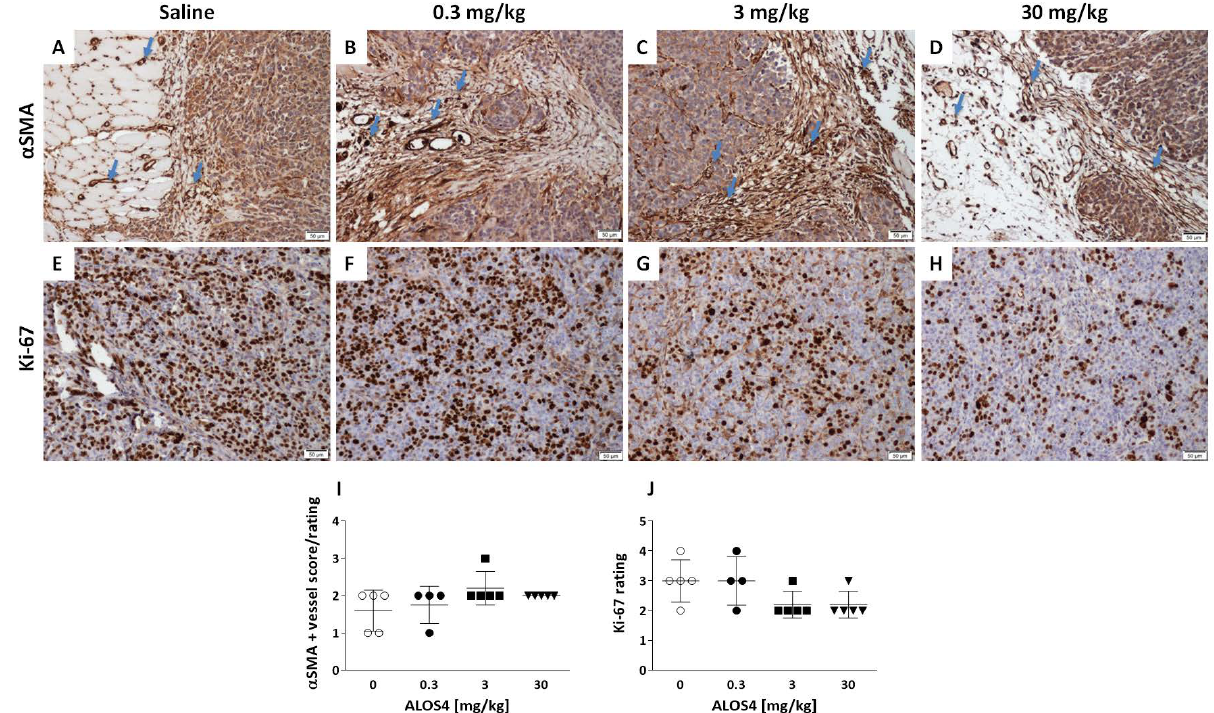
Figure 2. Effect of ALOS4 on carcinogenesis markers presentation in human melanoma A375 SC tumors from nude mice. ( A – D ) Representative photographs of slides stained for α SMA marker showing the number of blood vessels in the tissue sections (10 × ). Arrows demonstrate representative vessels in the tumor tissues. Scale: 50 µ m. ( A ) Tumor of a saline-treated mouse shows low to moderate α SMA expression. ( B ) Tumor of an ALOS4 0.3 mg/kg-treated mouse demonstrates relative moderate vascular density around and within the tumor tissue. ( C ) Tumor of an ALOS4 3 mg/kg- treated mouse demonstrates relative moderate to high vascular density around and within the tumor tissue. ( D ) Tumor of an ALOS4 30 mg/kg-treated mouse demonstrates relative moderate vascular density around and within the tumor tissue. ( E – H ) Representative photographs of slides stained for Ki-67 marker. ( E ) Tumor of a saline-treated mouse shows a high number of positive cells within the neoplastic cell population. ( F ) Tumor of an ALOS4 0.3 mg/kg-treated mouse demonstrates a high number of positive cells within the neoplastic cell population. ( G ) Tumor of an ALOS4 3 mg/kg-treated mouse demonstrates a moderate to low number of positive cells within the neoplastic cell population. ( H ) Tumor of ALOS4 30 mg/kg-treated mouse demonstrates a moderate to low number of positive cells within the neoplastic cell population. Scale: 50 µ m. ( I , J ) Quantification of histopathological evaluation scoring grades for α SMA ( I ) and Ki-67 ( J )